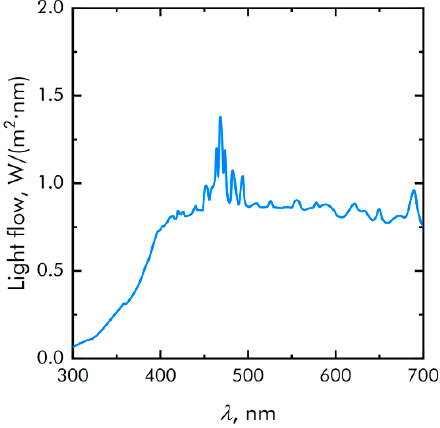
Figure 2. The spectrum of the light source.